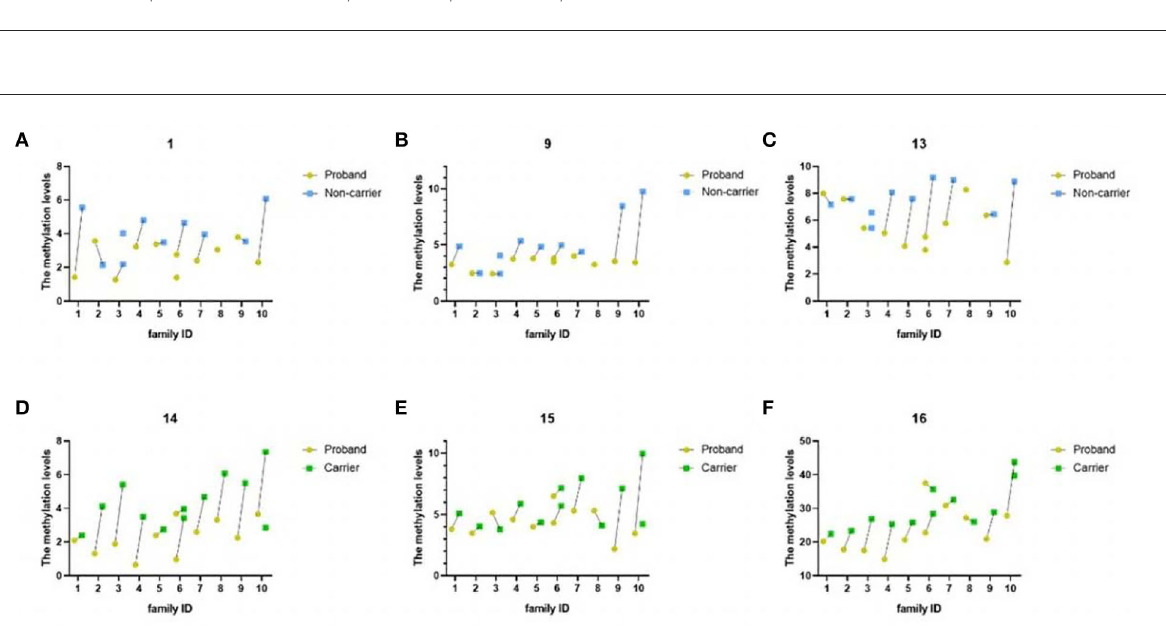
FIGURE4 The figure above showed methylation levels at six significantly different CpG sites of 10 FEVR families. The horizontal axis represented family ID and the vertical axis represented the methylation level of specific CpG site. (A–C) DNA methylation levels of CpG1, CpG9 and CpG13 were significantly different between probands and non-carriers. Yellow and blue points indicated to probands and non-carriers, respectively. (D–F) DNA methylation levels of CpG14, CpG15 and CpG16 were significantly different between probands and carriers. Yellow and green points indicated to probands and carriers,